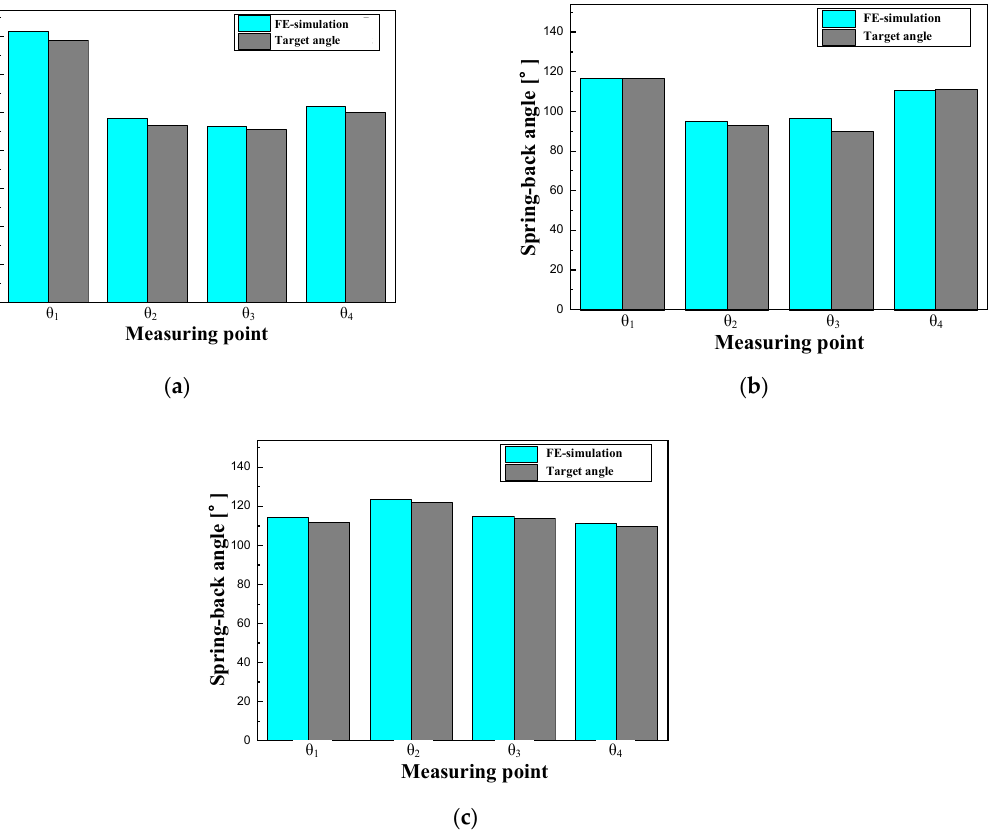
Figure 6. Comparison of the spring-back between the analytical results and target angle. ( a ) Cross- section at A. ( b ) Cross-section at B. ( c ) Cross-section at